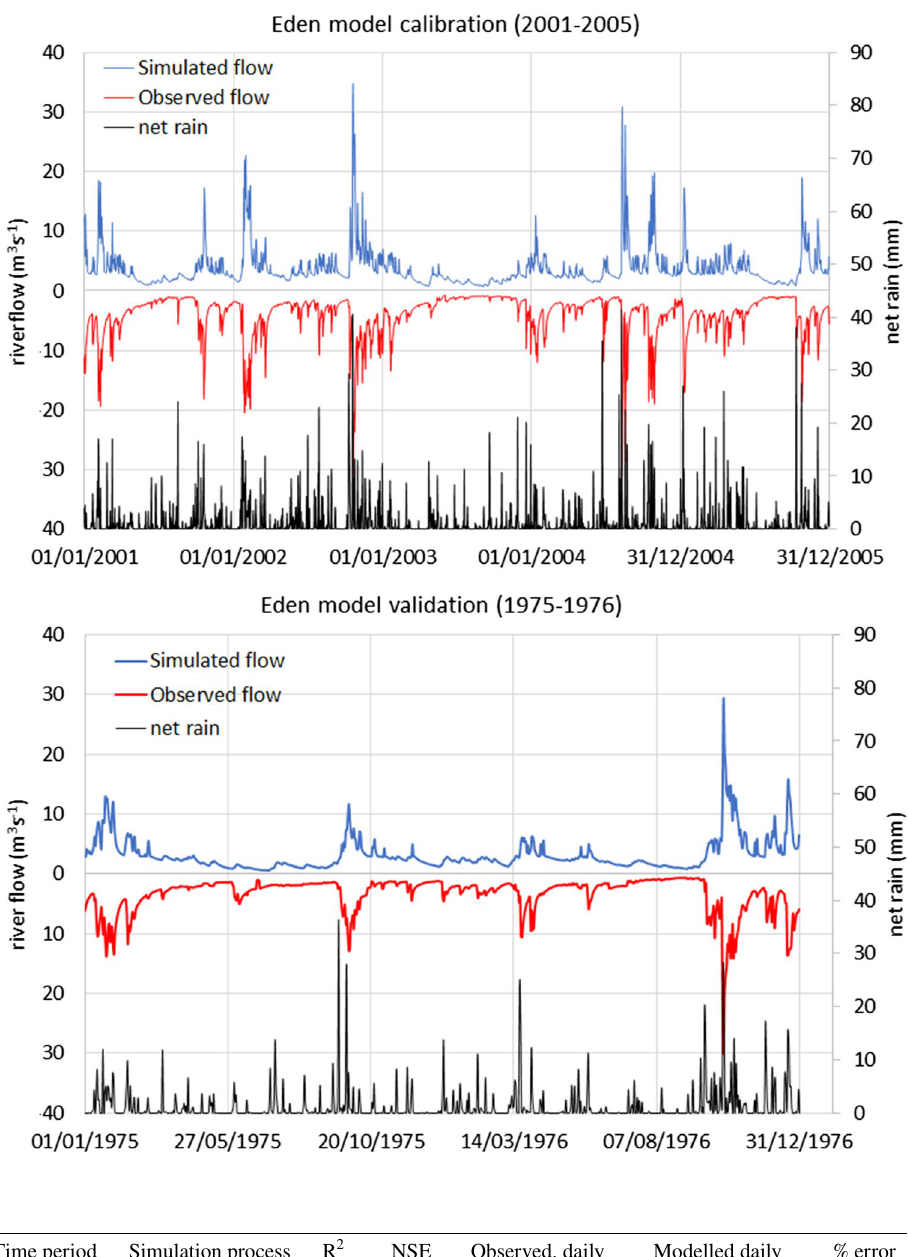
Fig. 7 DiCaSM model calibra- tion for the year 2001–2005 (top) and validation for the year of 1975–1976 drought period (bottom)